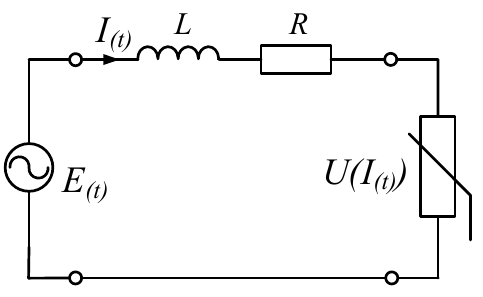
Figure 1. Diagram of the analyzed